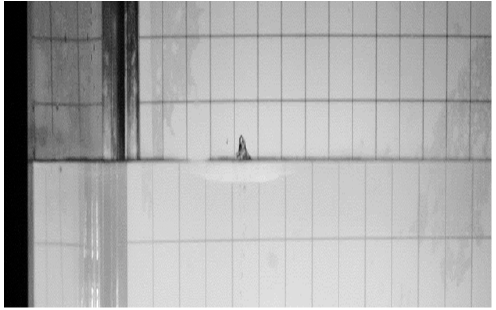
Figure 11. The splash diagram of the hydrophilic model with the initial velocity of water entry v = 2.2 m/s and the head shape hemispherical angle of 0°.